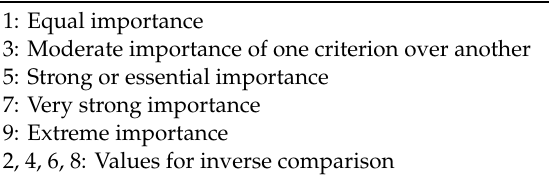
Table 8. Scale of Criteria comparison [29].